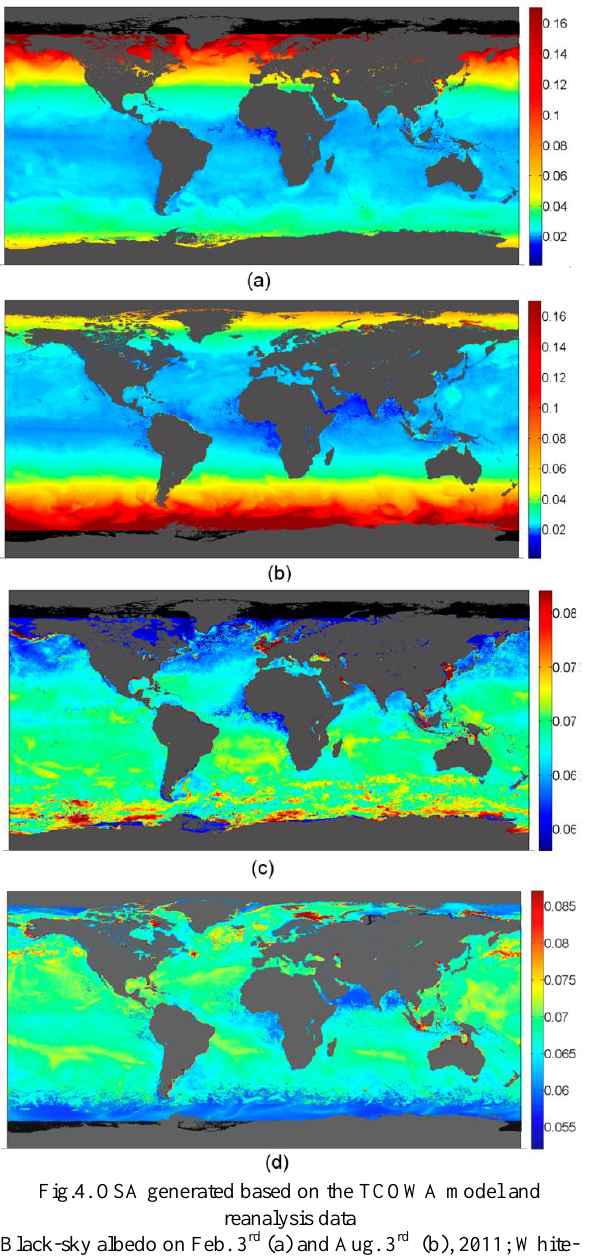
Fig.4. OSA generated based on the TCOWA model and reanalysis data Black-sky albedo on Feb. 3 rd (a) and Aug. 3 rd (b), 2011; White- sky albedo on Feb. 3 rd (c) and Aug. 3 rd (d), 2011. SZA more than 88 ° is voided and marked in black. Fig.5. GLASS phase-2 surface broadband albedo product (a) shortwave, (b) visible, and (c) near infared bands Surface broadband albedo at June 18th, 2007, where the voided value was marked with